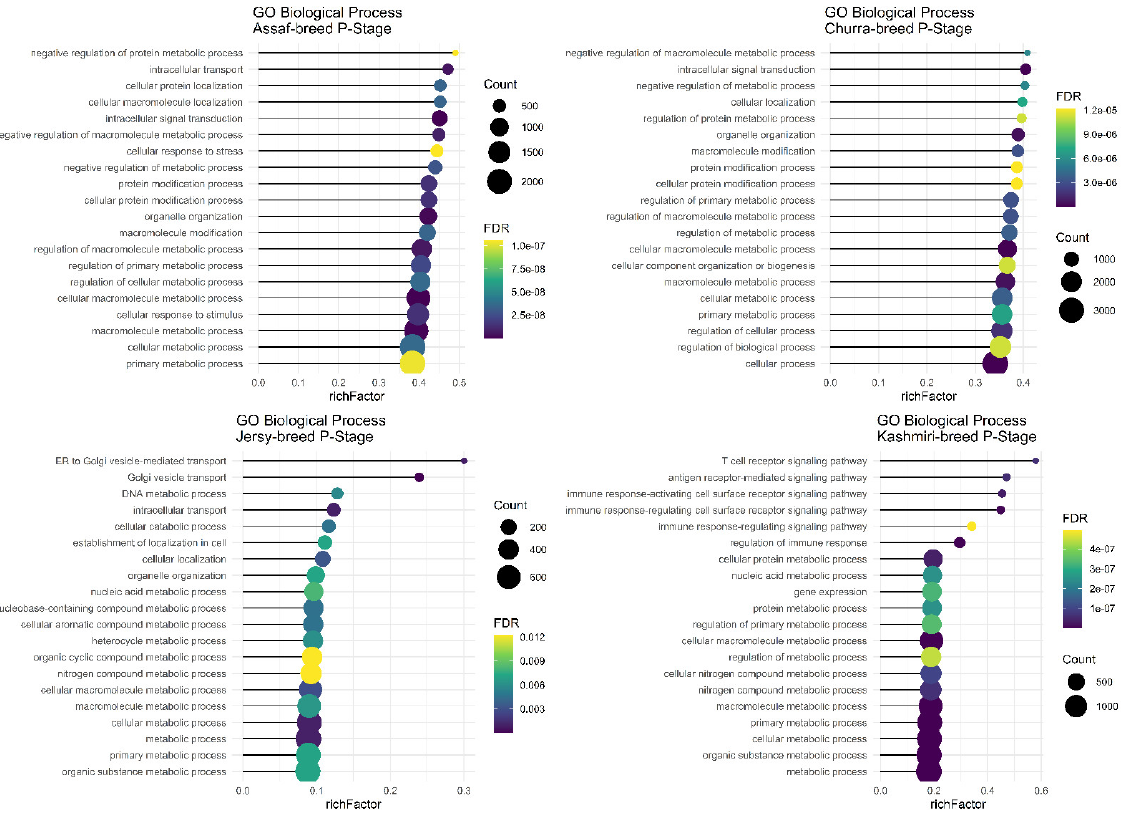
Figure 5. Functional enrichment analysis results of P stage in Assaf, Churra, Jersy, and Kashmiri breeds. Since the significant biological process term is large, only 20 top significant terms are shown. The color and size of points indicate FDR and the number of genes associated with each term,